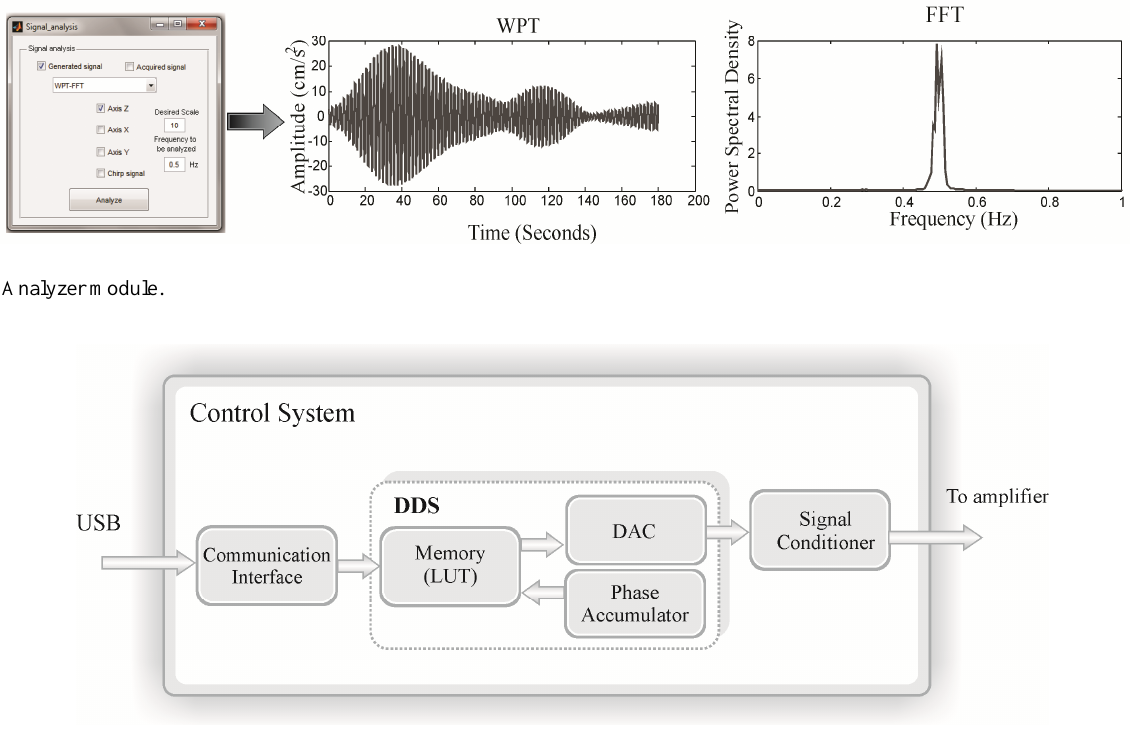
Fig. 6. Control system